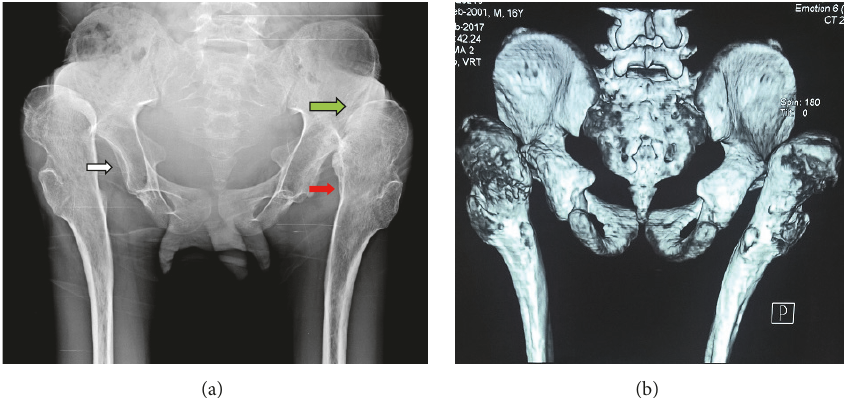
Figure 5: Anteroposterior radiograph of pelvis with both hip joints (a) showed widening of pubic symphysis, bilateral shallow acetabulum (white arrow), abnormal contour of bilateral femoral head with increased neck shaft angle (coxa valga deformity) (red arrow), enlarged and elongated bilateral greater trochanter, superolateral migration of bilateral femoral head overlying adjacent to iliac bones (green arrow), and slender proximal femoral shafts. CT of pelvis (b) confirming pubic diastasis, bilateral shallow acetabulum, bilateral coxa valga deformity, bilateral hip dislocation, and pseudoarticulation of the left femoral head with iliac bone.